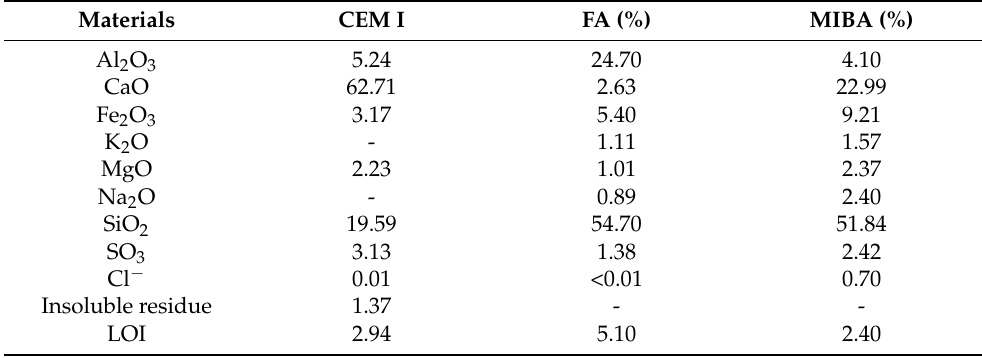
Table 2. Chemical composition of raw materials, cement type I, fly ash (FA) and municipal solid waste incinerator bottom ash (MIBA) (% by